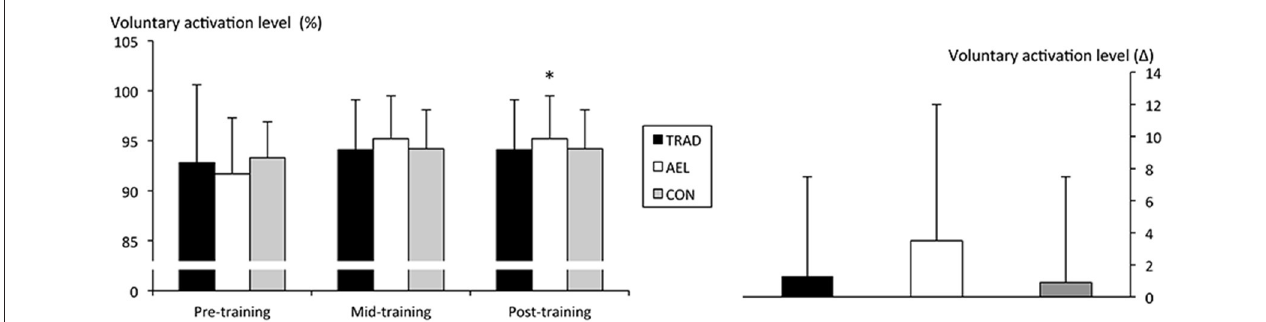
FIGURE 5 | Voluntary activation level (mean ± SD ) during unilateral isometric knee extension. * p < 0.05 vs. pre-training.